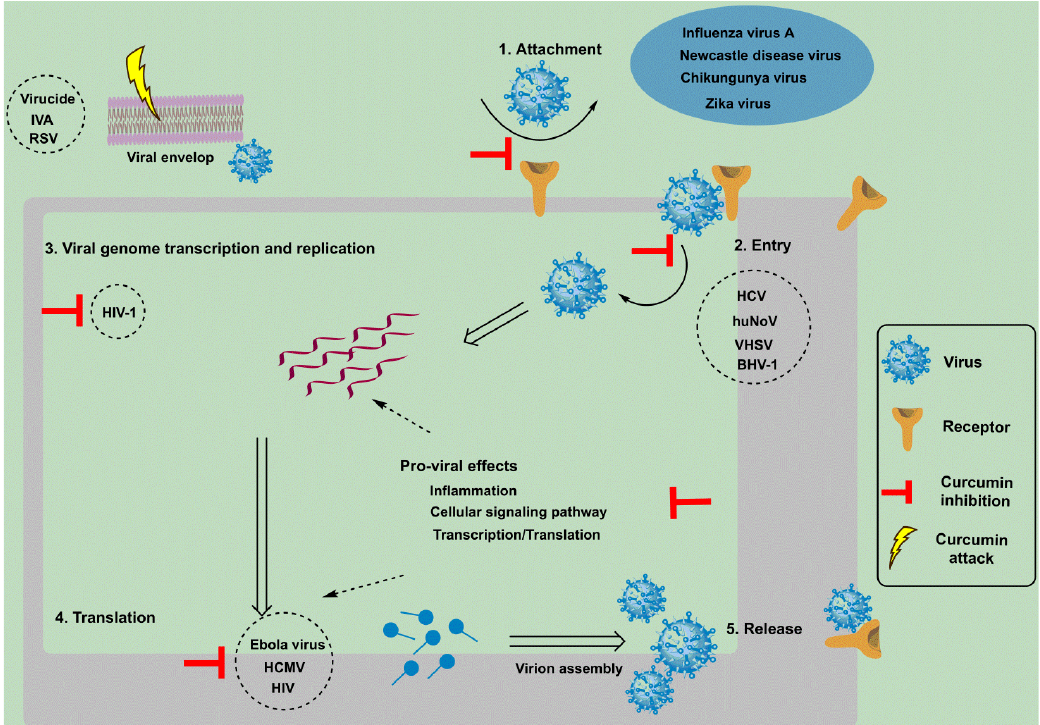
Figure 3. Antiviral mechanism of curcumin in the host cell. Chemotherapeutic action is attracted to certain crucial stages in the viral life cycle. These steps include the attachment of the virion to its cellular receptor, its consecutive entry, followed by the viral genome transcription and replication step, and then its translation, virion assembly, and finally release. Curcumin inhibits the action of viral envelope proteins, preventing viral attachment and entry. In addition, certain signaling path- ways, inflammation, and translation/transcription machineries are modulated by curcumin that then becomes block viral replication. Apart from this, curcumin disrupts the integrity of the viral envelope and thus acts as a virucidal agent. A few of the viruses against which curcumin has shown a versatile antiviral effect are shown in the circles.